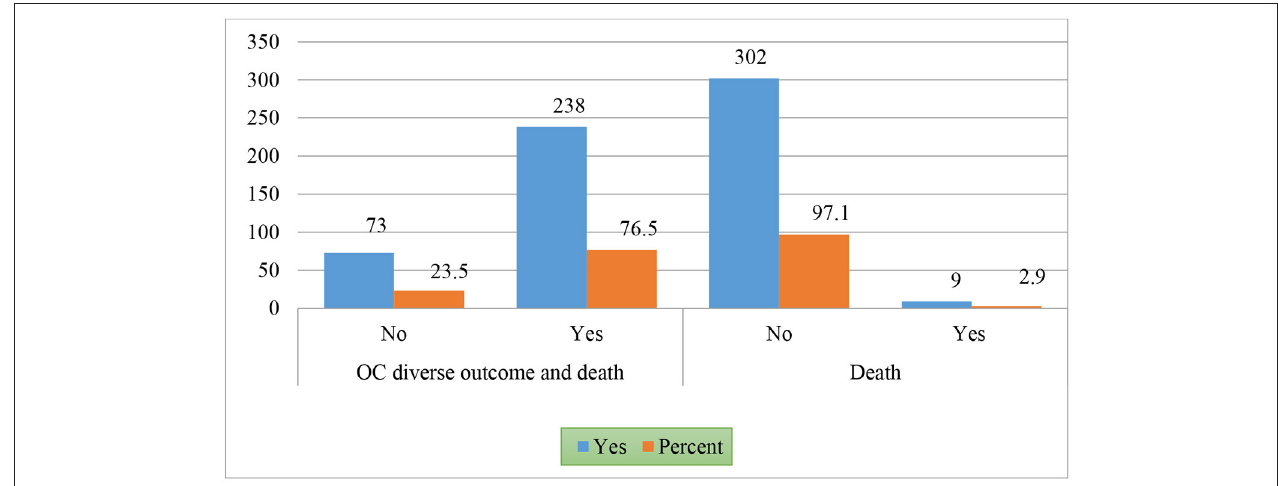
FIGURE 1 | An oral cancer adverse outcome and